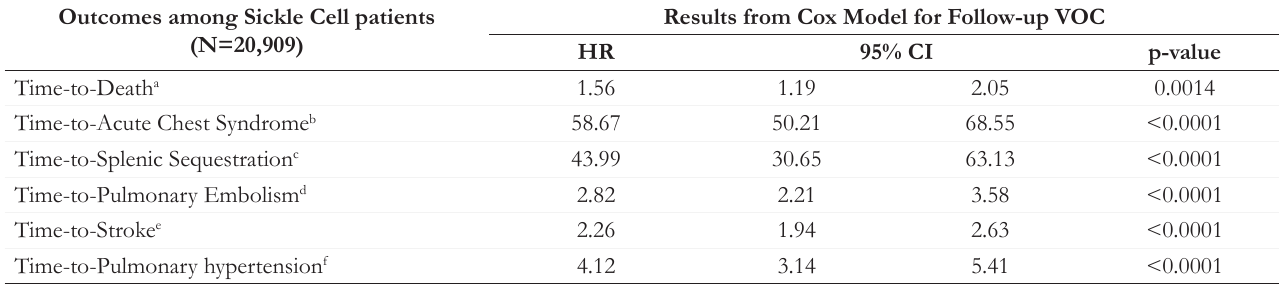
Table 2. Cox Model to Examine the Relationship between VOC and Complications Outcomes among Sickle Cell